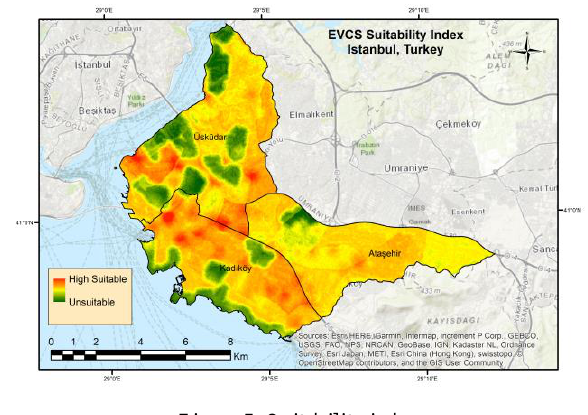
Figure 5. Suitability